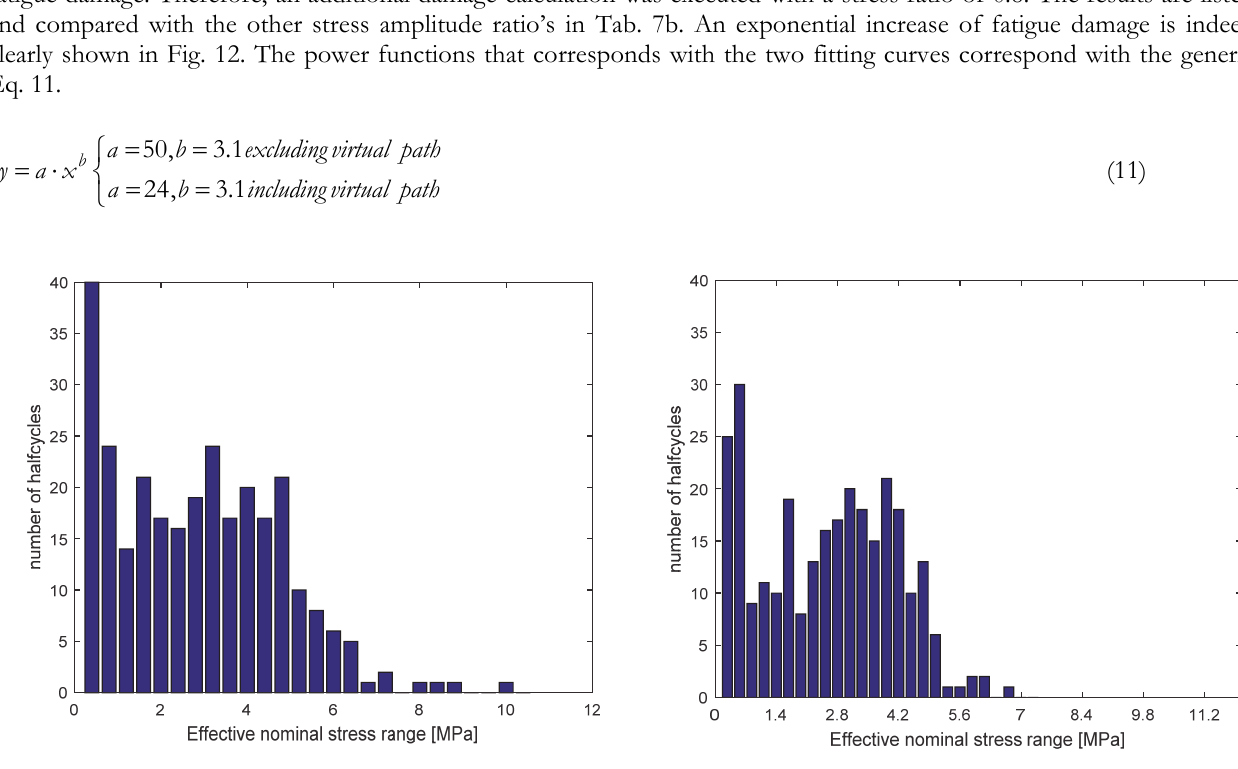
Figure 11: Histograms resulting from PDMR cycle counting of the load path depicted in Fig. 4 (right); Virtual path included (left) and excluded (right).